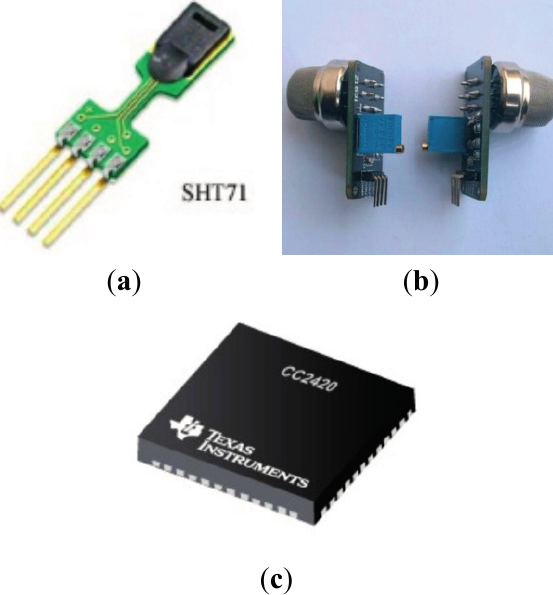
Figure 7. The modules chosen in the design. ( a ) temperature sensing module; ( b ) photoelectric smoke module; ( c ) radio frequency module.